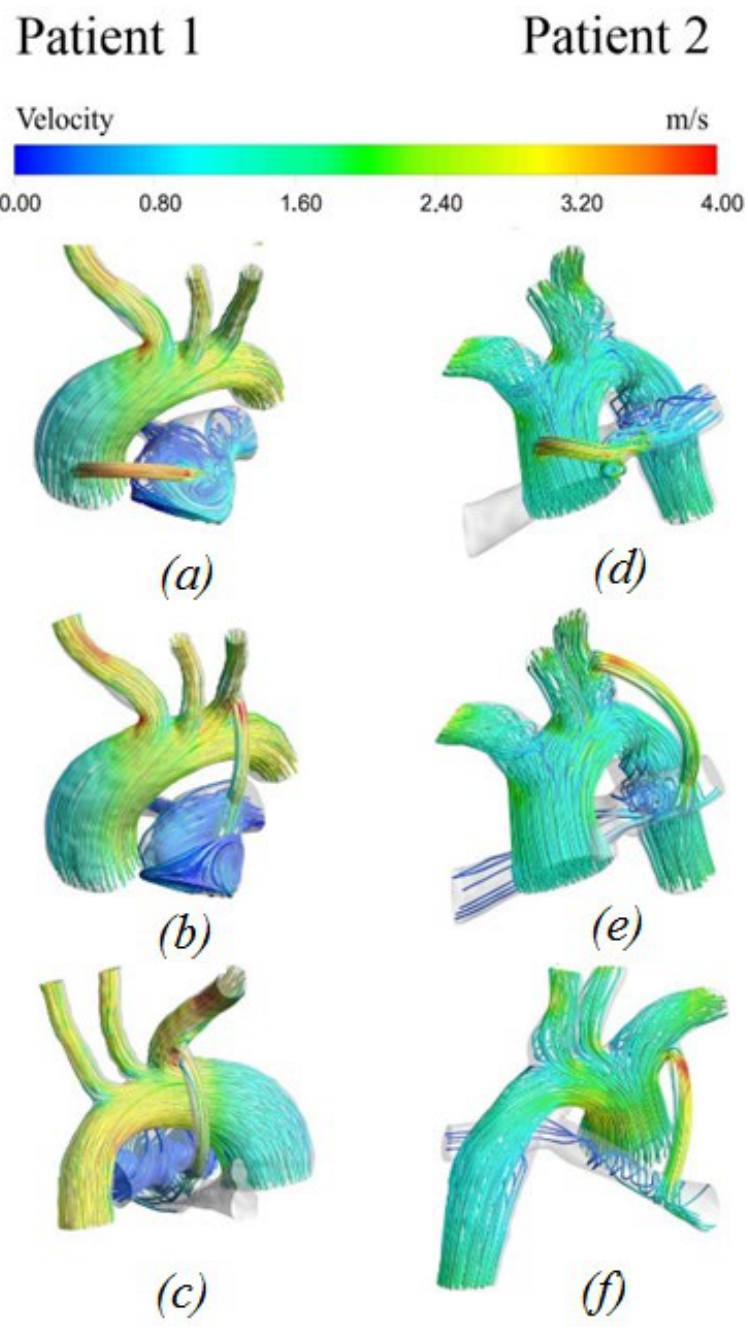
Figure 6. Velocity distribution with anisotropic properties of the aorta and hyperelastic properties of the shunt: ( a , d ) central shunt; ( b , e ) right shunt; ( c , f ) left shunt.